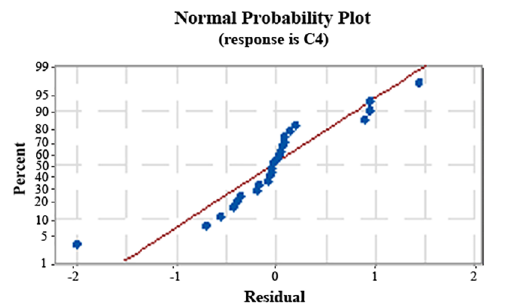
Figure 7. Normal probability of regression equation for tensile load.